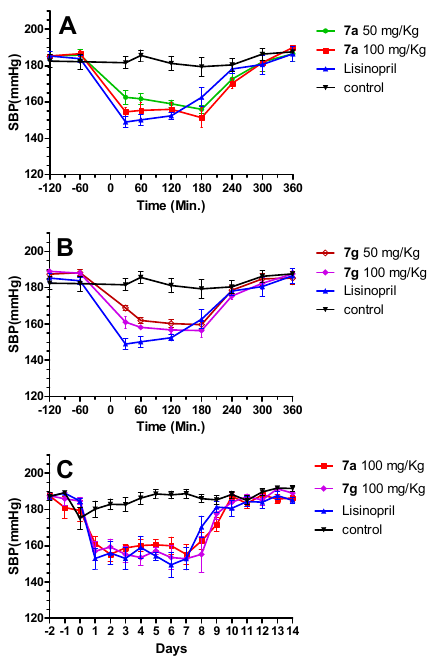
Figure 4 . ( A , B ), the acute antihypertensive activity of compounds 7a and 7g in spontaneously hypertension rats (SHRs) for single dose administration (dosing time: 0 min); ( C ) the